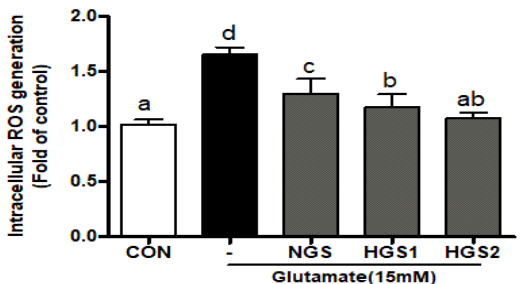
Figure 3. Inhibitory effect of HGS on glutamate-induced oxidative stress in PC12 cells. The cells were treated with HGS (20 μg/mL) or the control (0.2% DMSO) for 24 h and stimulated with glutamate (10 mM) for 4 h. ROS generation in PC12 cells was observed by fluorescence microscopy. Absorbance was measured after the DCF-DA staining of cells treated with glutamate or glutamate and HGS. Data are means ± standard errors of the mean (SEM). Significance was determined by a one-way ANOVA with Tukey’s post hoc multiple comparison test; The values marked by different letters in a, b, c and d were found to differ significantly at p < 0.05 by Duncan’s multiple range test.